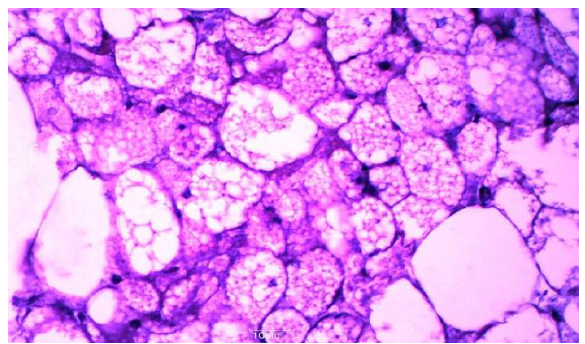
multivacuolated, granular cells and univacuolated